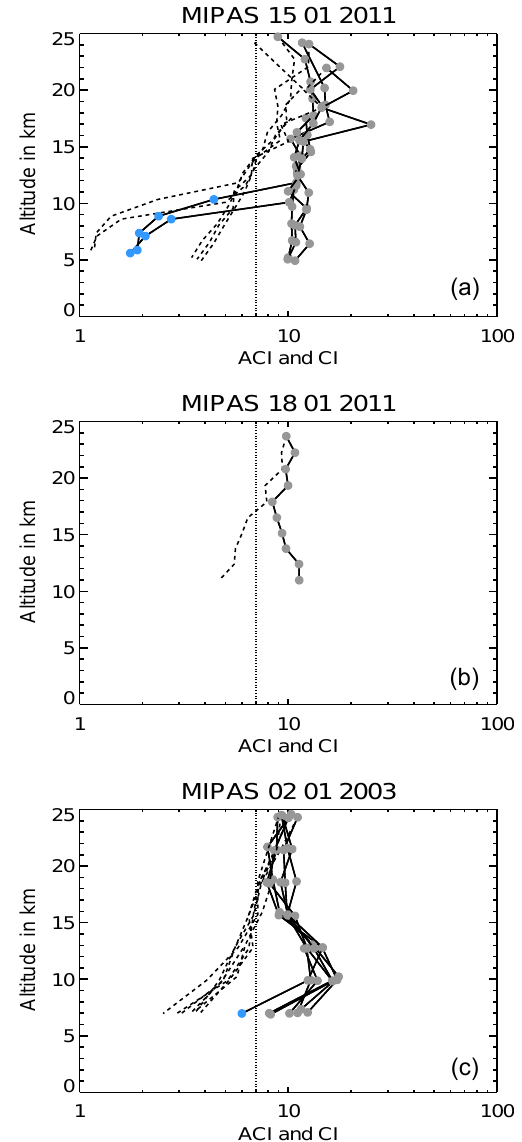
Figure A4. Measured ACI (solid lines) and CI (dashed lines) pro- files for (a) polar winter 2011 (70–90 ◦ N, 0–2.5 ◦ E), (b) tropics 2011 (0–30 ◦ S, 110–120 ◦ E), and (c) tropics 2003 (0–20 ◦ N, 30– 60 ◦ E). Grey dots indicate clear air spectra and blue dots indicate spectra affected by ice clouds according to the method presented in Sect.